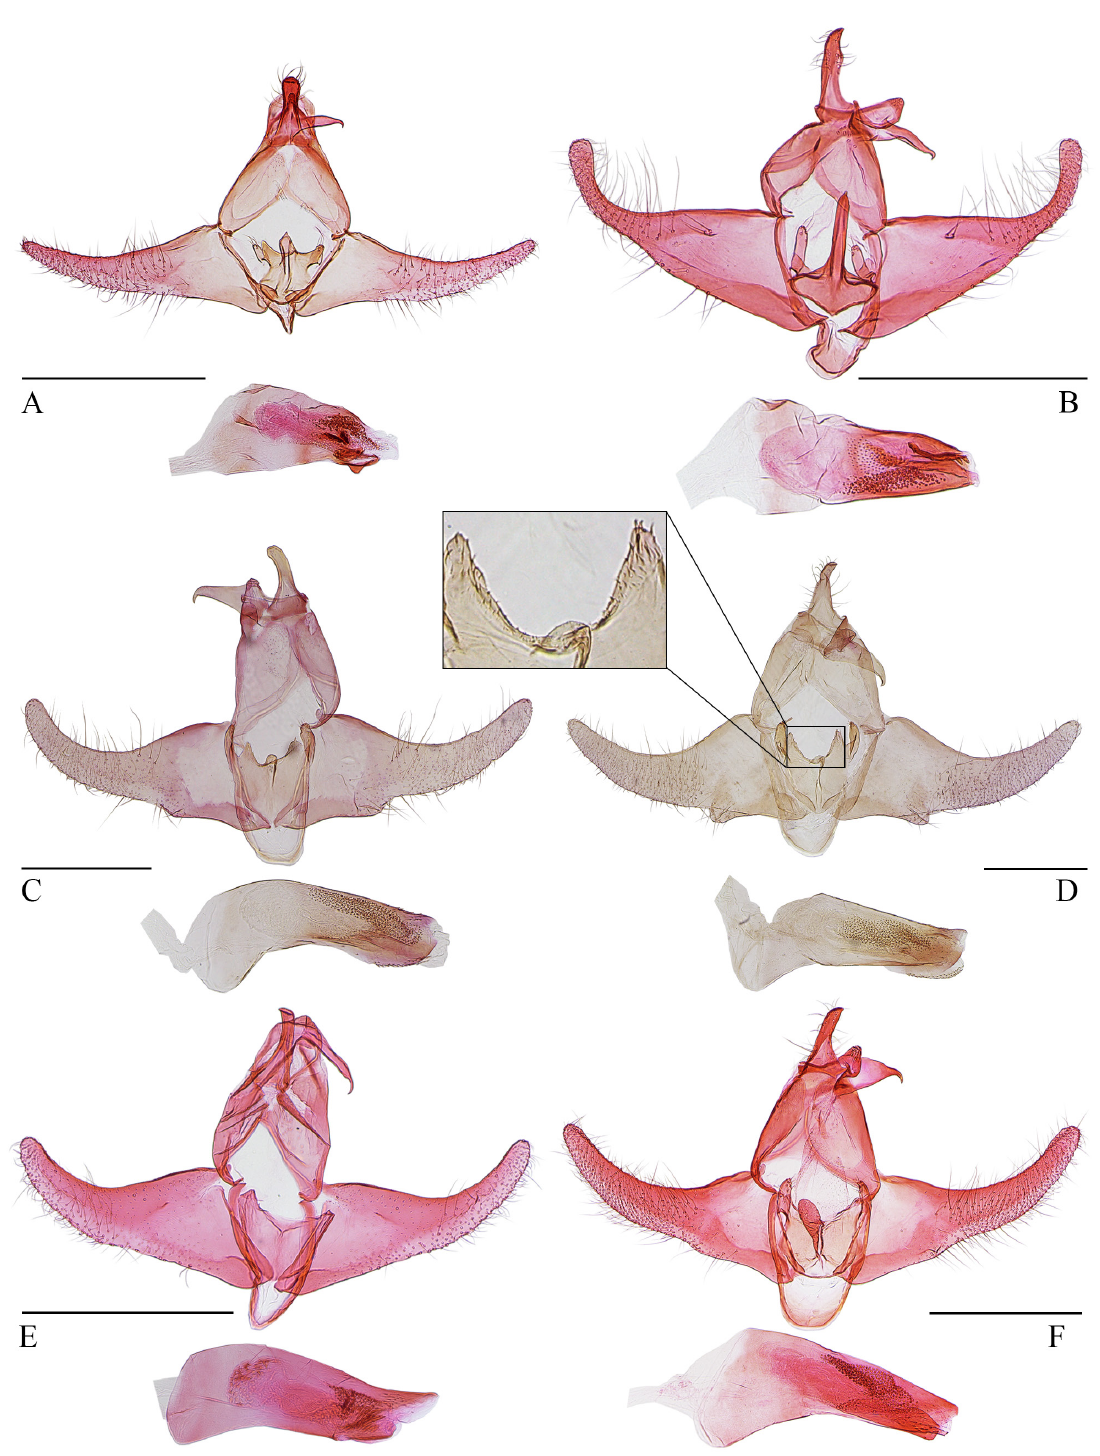
Fig. 3. Male genitalia of Antiochtha spp. A . A. erromera sp. nov., holotype, slide No. YS20048. B . A. hainanensis sp. nov., paratype, slide No. YS20058. C . A. jianfengensis Zhu & Li, 2009, holotype, slide No. ZYM06433. D . A. jianfengensis , holotype of A. rotunda syn. nov., slide No. ZYM06040. 0.5